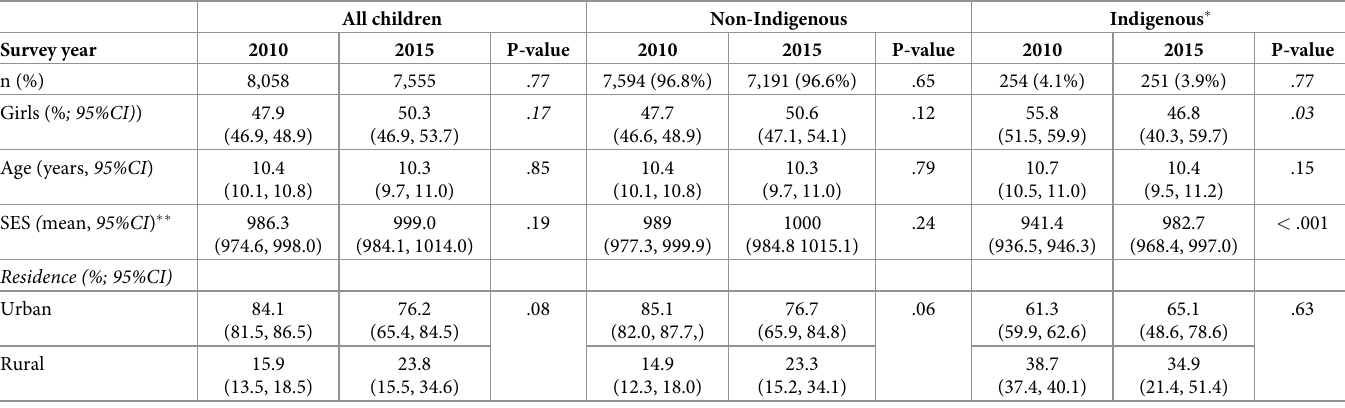
Table 1. Characteristics of the sample by population groups and survey